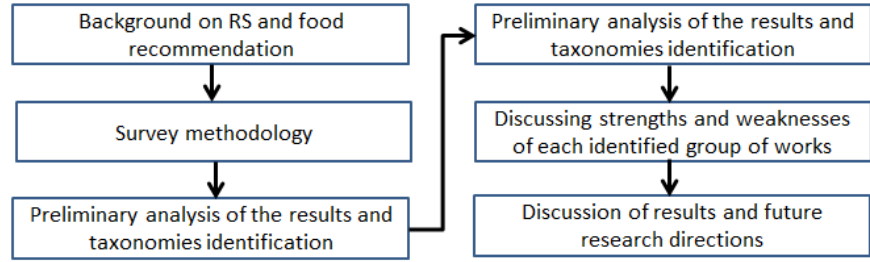
Figure 1. Flow of this